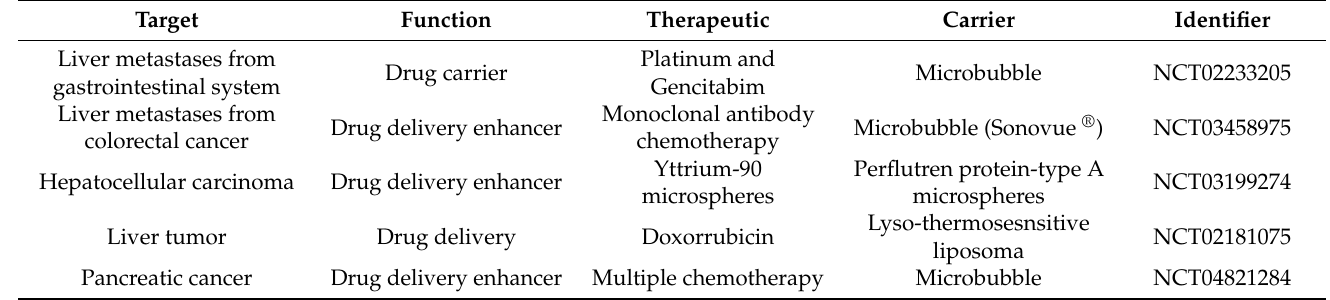
Table 2. Summary of clinical trials using ultrasound-mediated therapeutics for cancer applications. Target Function Therapeutic Carrier Identifier Liver metastases from Platinum and Drug carrier gastrointestinal system Drug delivery